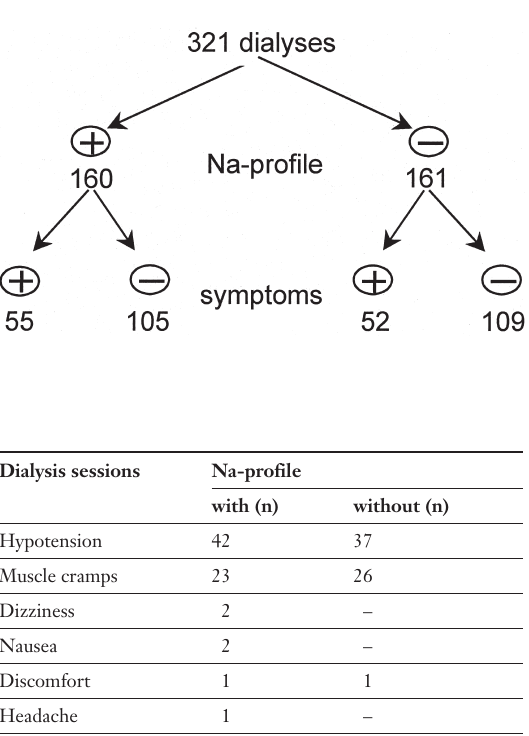
Changes in weight, hemat- ocrit and blood- volume with and without Na-profile (mean ± SD, Stu- dent’s